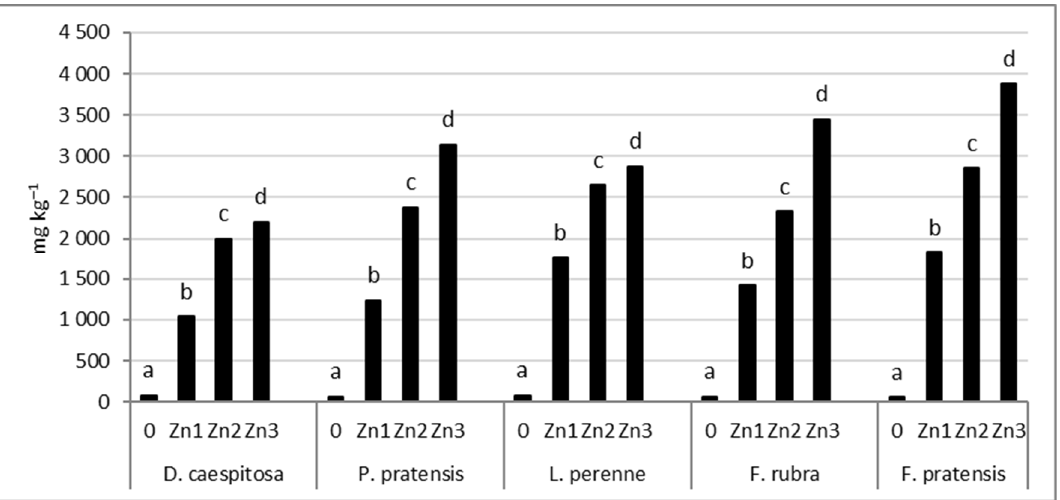
Figure 6. Zn concentration in shoots. Values marked with the same letters within one species do not differ significantly, according to Tukey’s test ( p < 0.05).